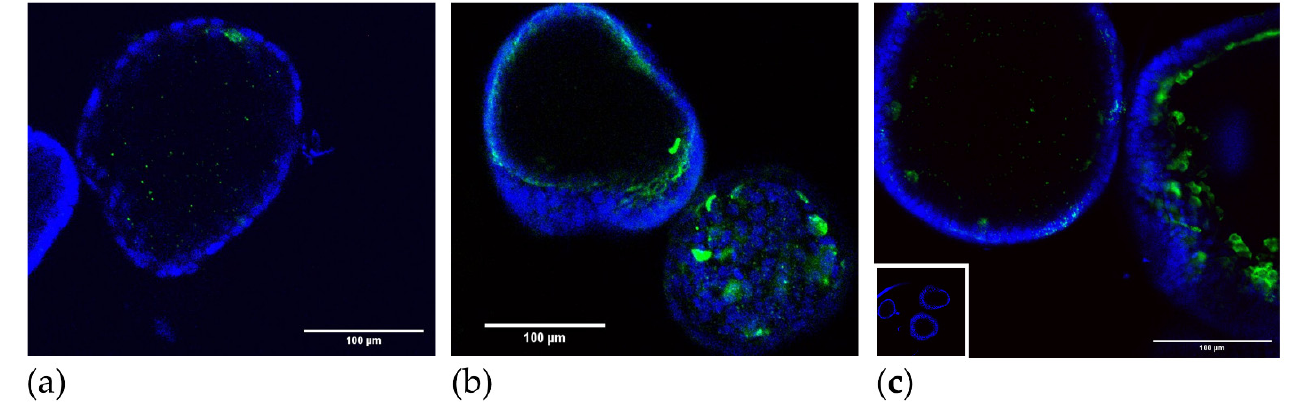
Figure 3. Localization of SSEA-1 in MFO ( a ), EMO-H ( b ), and ( c ) EMO. Inset: IgM control. Bar 100 µm.